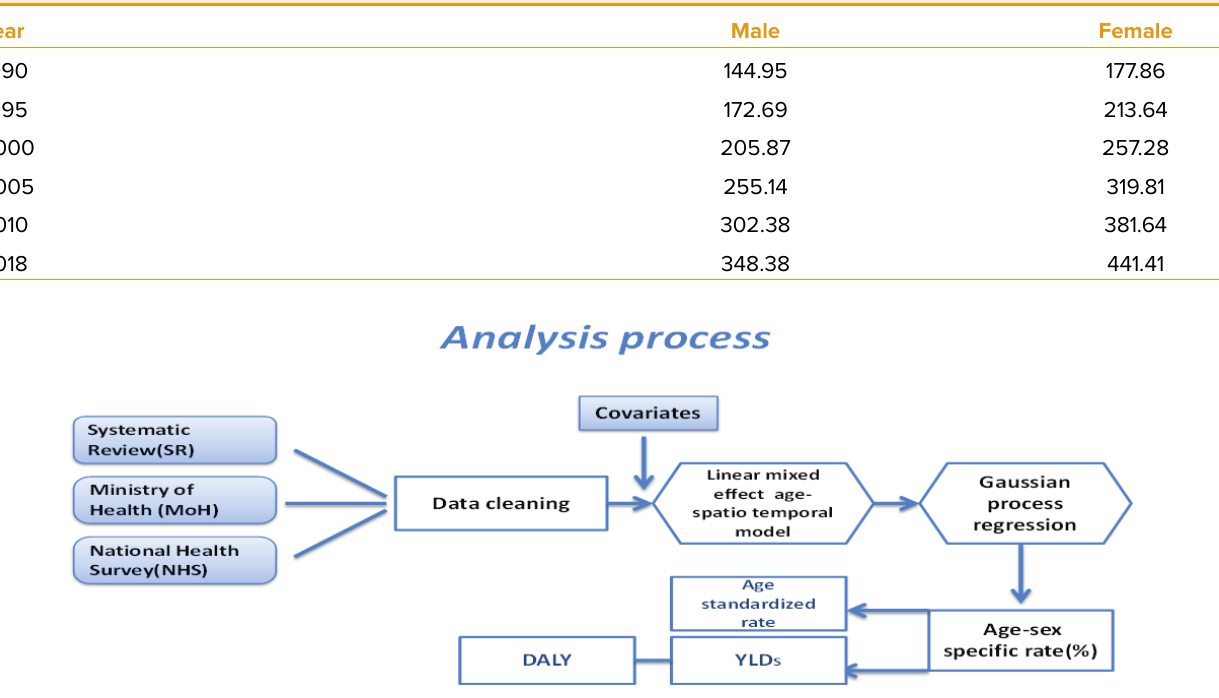
Figure 1. Analysis process for YLDs calculation. DALY, disability-adjusted life years; YLD, years lived with